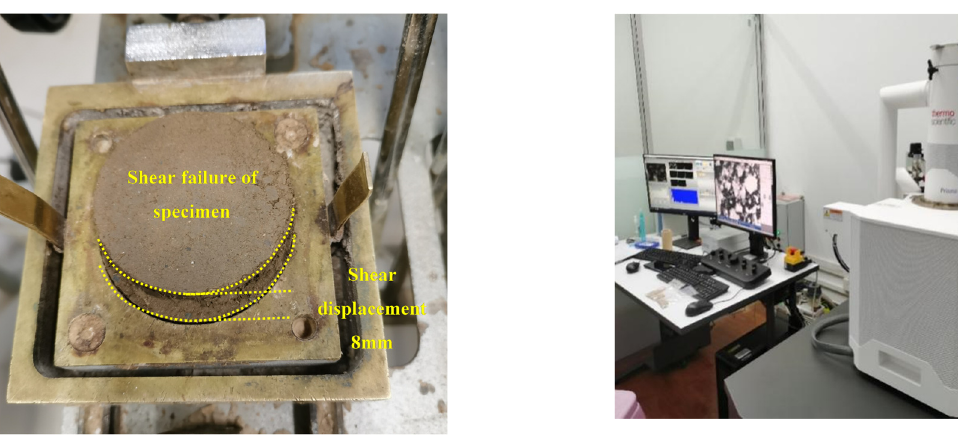
Figure 9: Shear failure of test block.